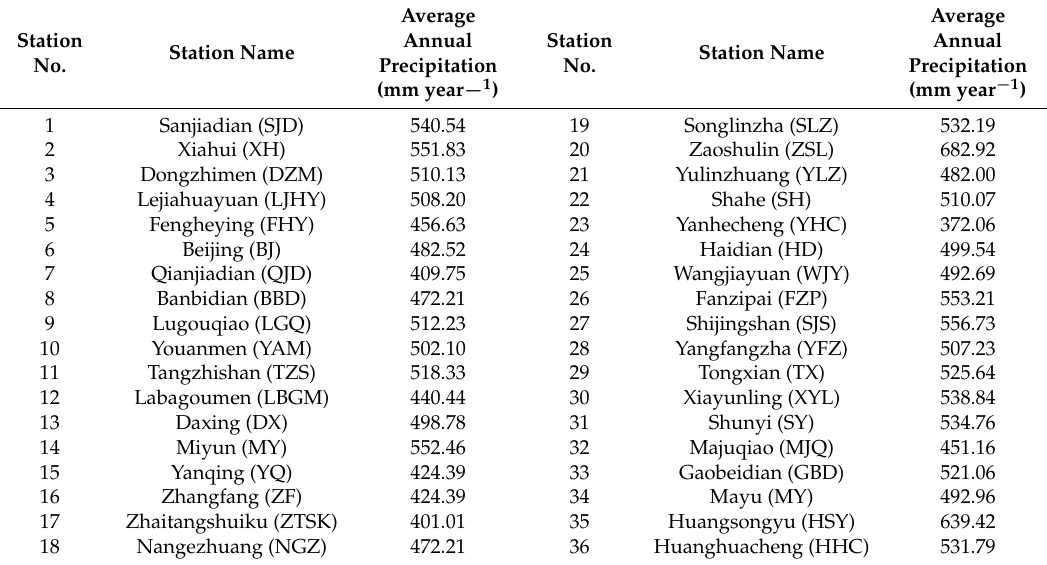
Table 1. Information on the 36 ground observation stations in Beijing used in this study. Station